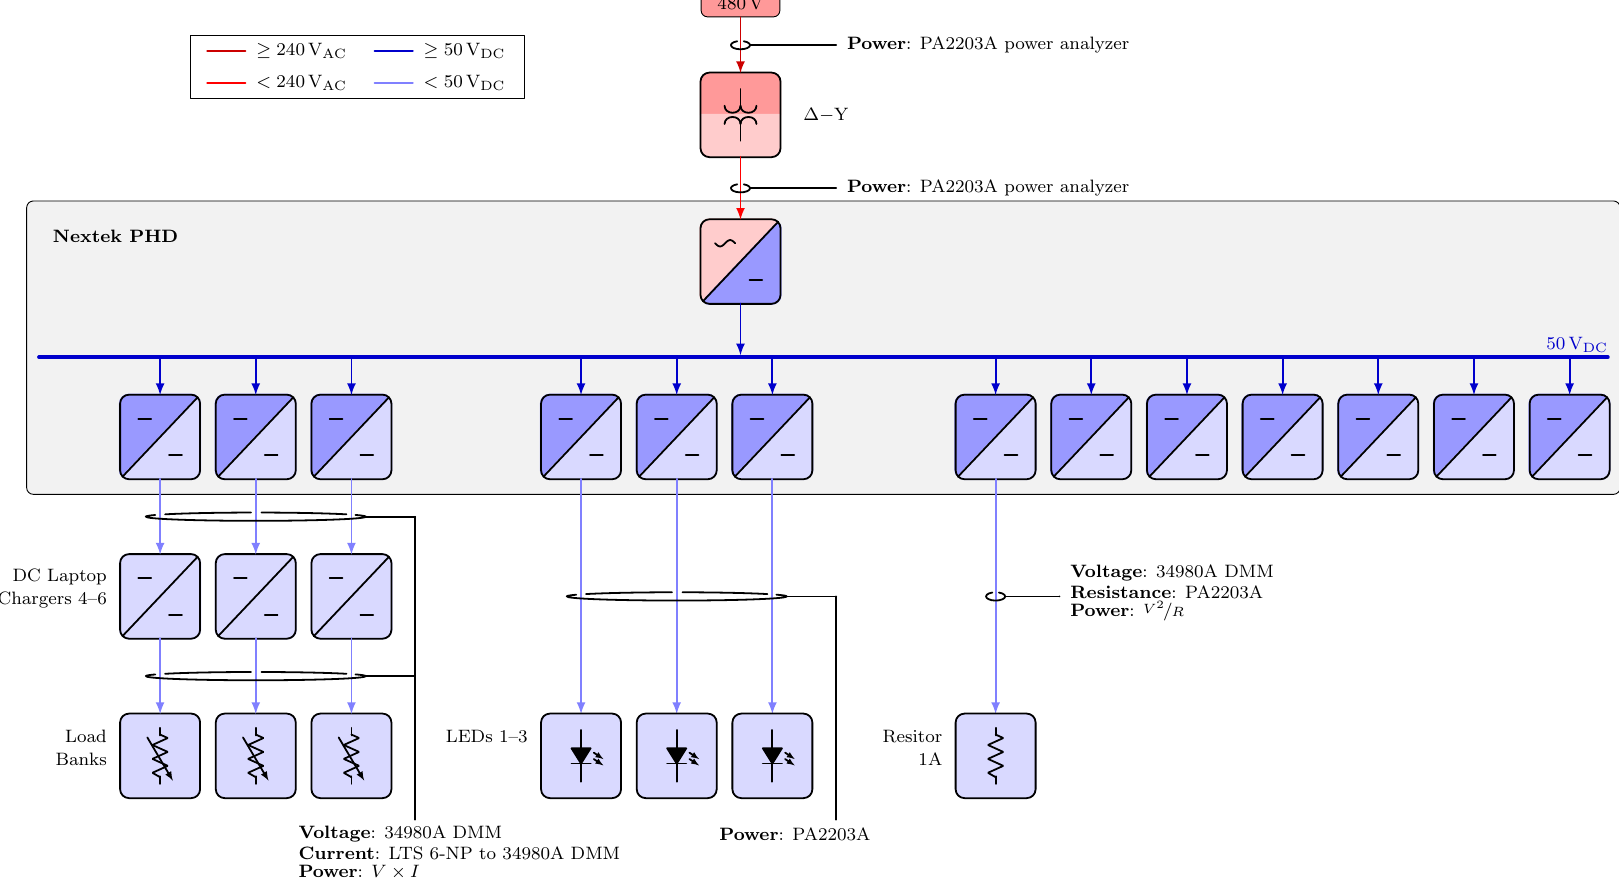
Figure A5. Electrical diagrams for Scenarios 5.2 and